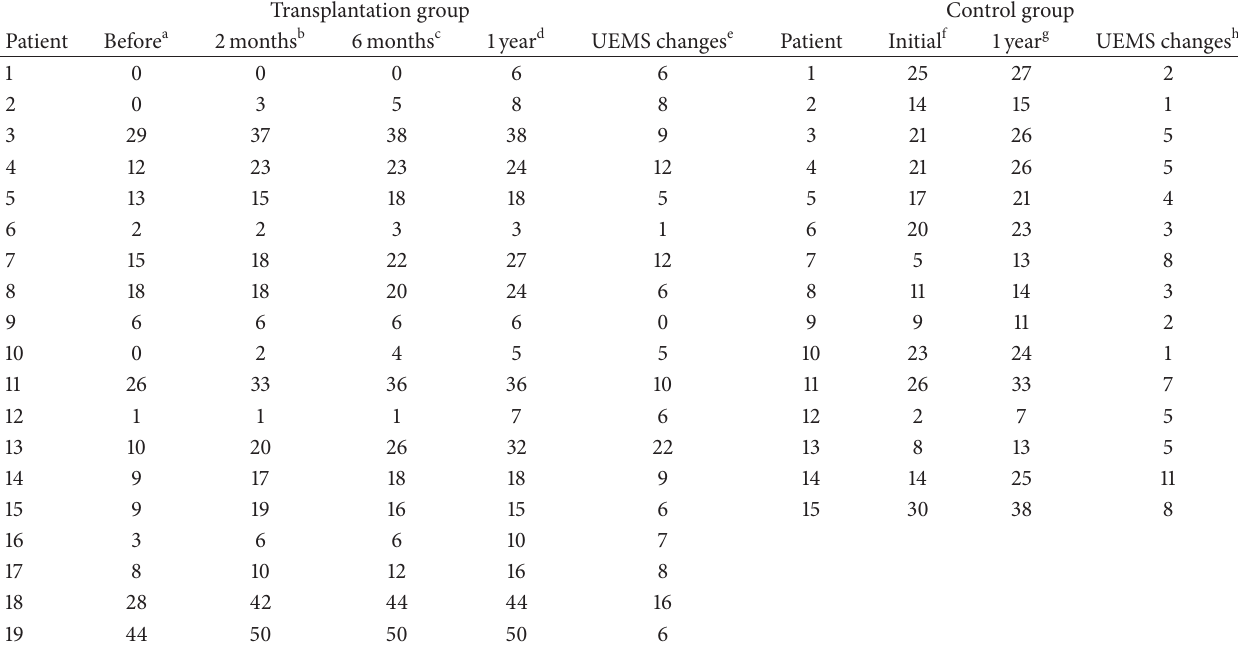
Table 6: AMS upper extremity motor score (UEMS).